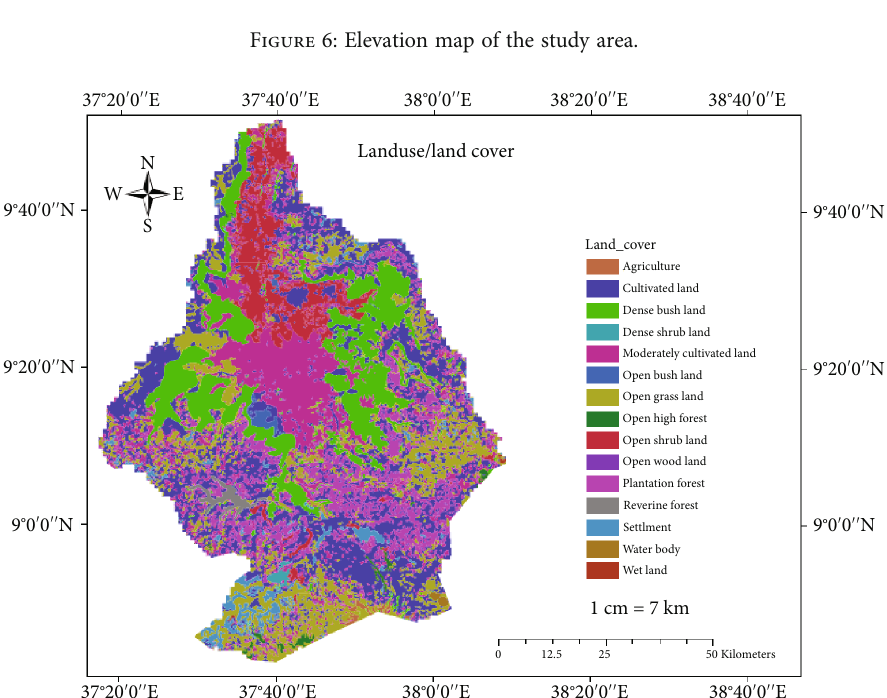
Figure 6: Elevation map of the study area.